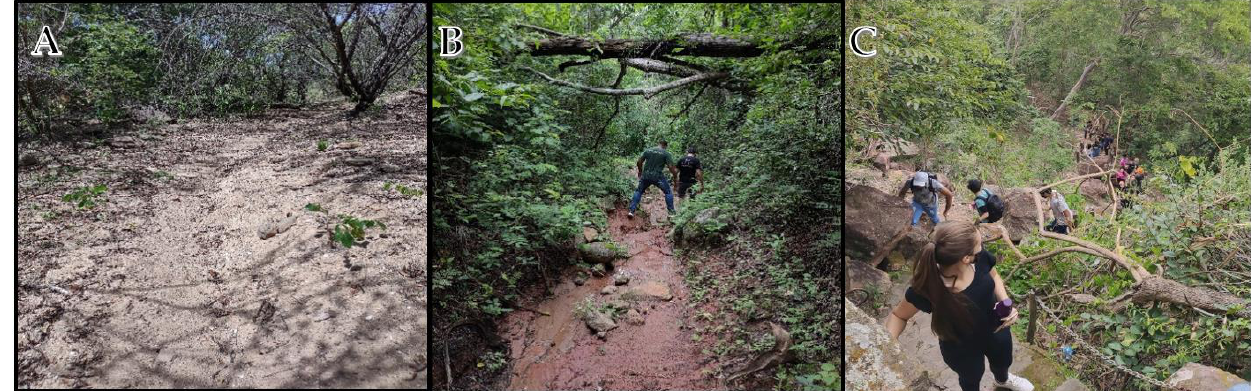
Figure 10. Surface ground and altimetric variations. ( A ) — Missão Velha Waterfall Trail: predominantly flat altimetry, regular surface with burlap, sandy and stable floor; ( B ) — Sítio Fundão Trail: predominantly irregular altimetry, little unevenness, surface of the with burlap, stony floor, with waterlogged and slippery stretches; ( C ) — Pontal da Santa Cruz Trail: predominantly steep altimetry, irregular surfaces with burlap, stretches with stones and stable projected rocky floor (steps); Araripe UGG. Source: Research Collection.